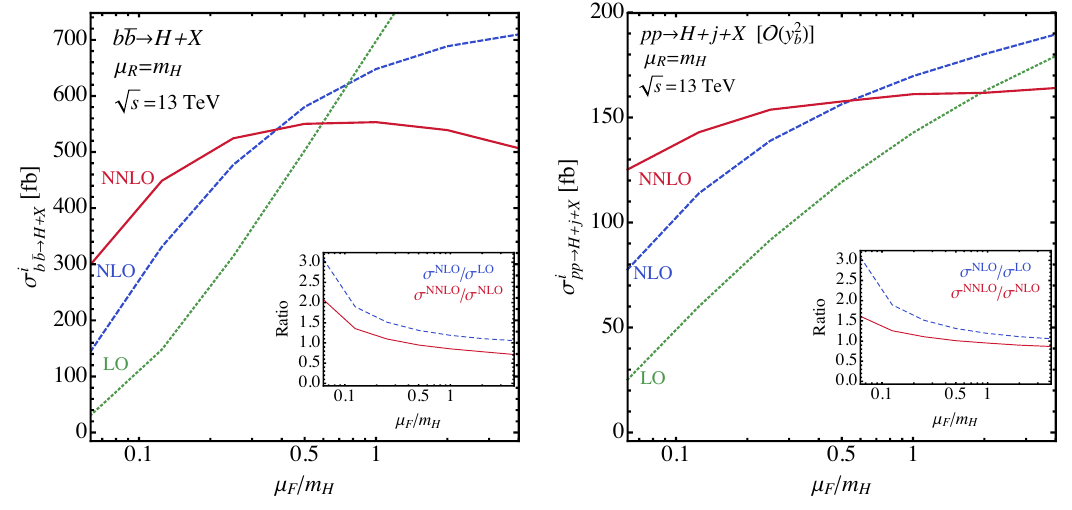
Figure 6 . Main figures: dependence of the LO, NLO, and NNLO cross sections on the factorization scale (left: H + 0 j , right: H + 1 j ). Insets: ratio of the NNLO prediction to the NLO (red) and ratio of the NLO prediction to LO (blue,